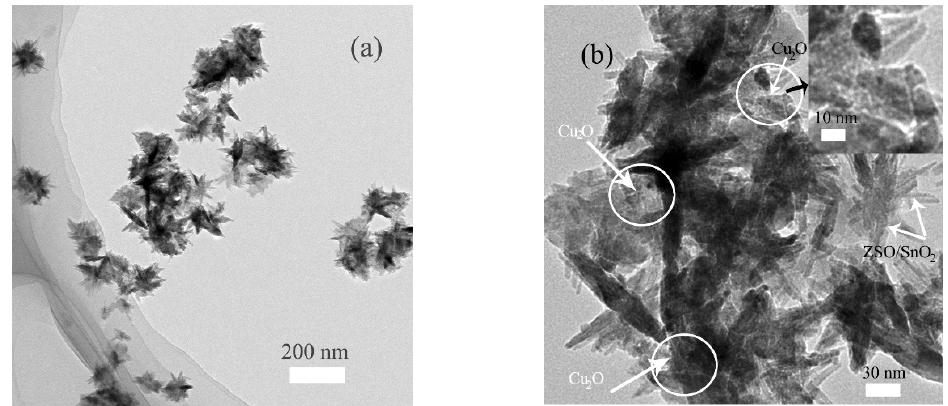
Figure 2. ( a ) Low-magnification TEM image, and ( b ) high-magnification TEM image as well as partially magnified image in the inset of the ZSC1.5 sample.